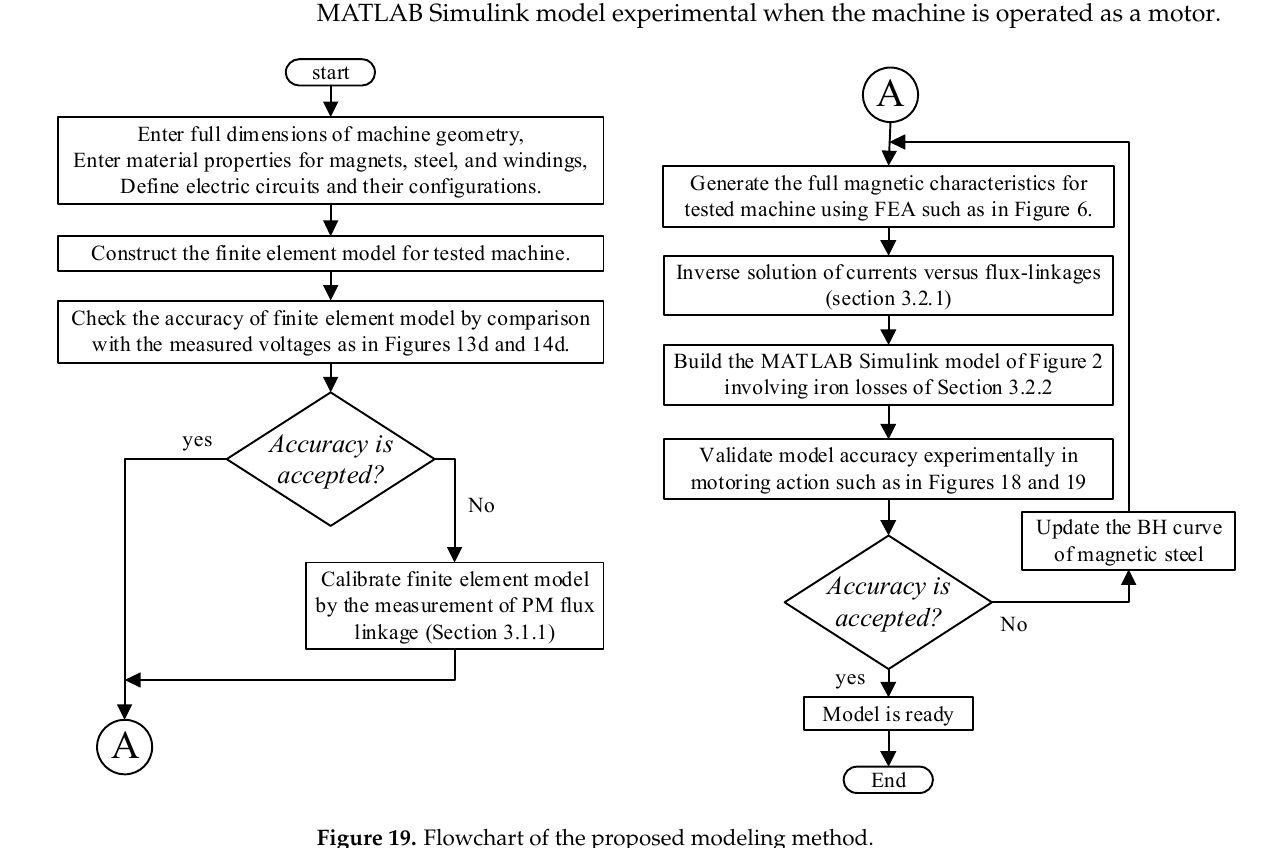
Figure 19. Flowchart of the proposed modeling method.